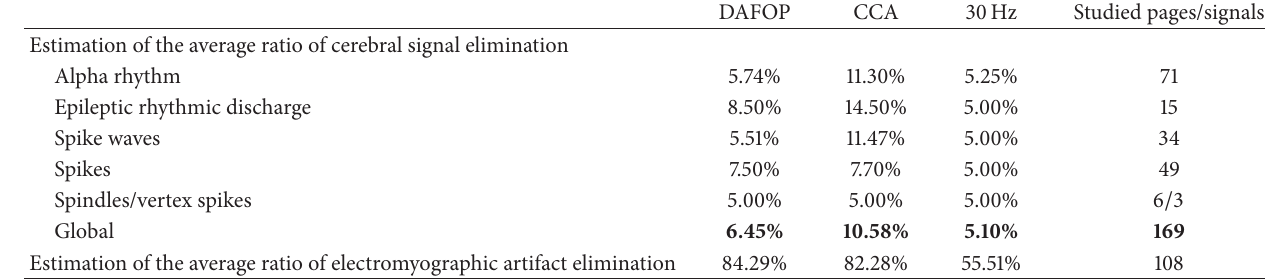
Table 1: Estimation of average ratios of artifact/cerebral signal